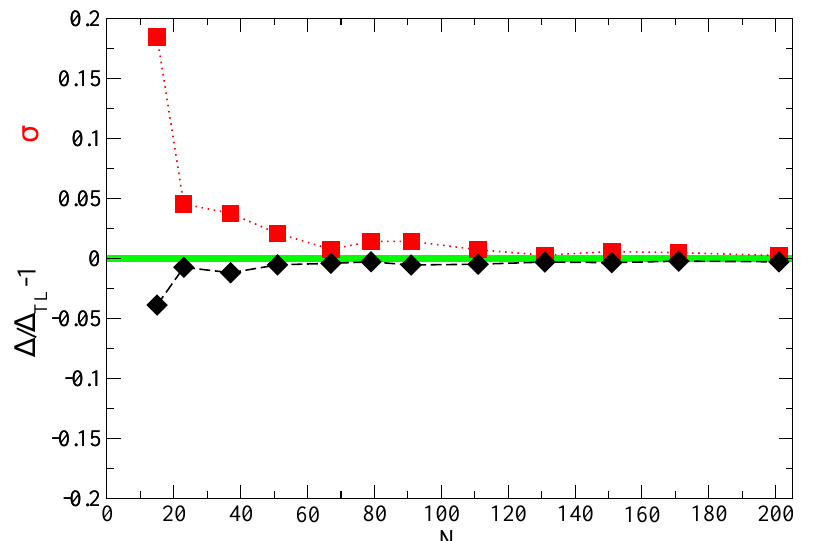
Figure 10. The variation σ of the OES across the twist angles compared to the FSEs of the twist- averaged